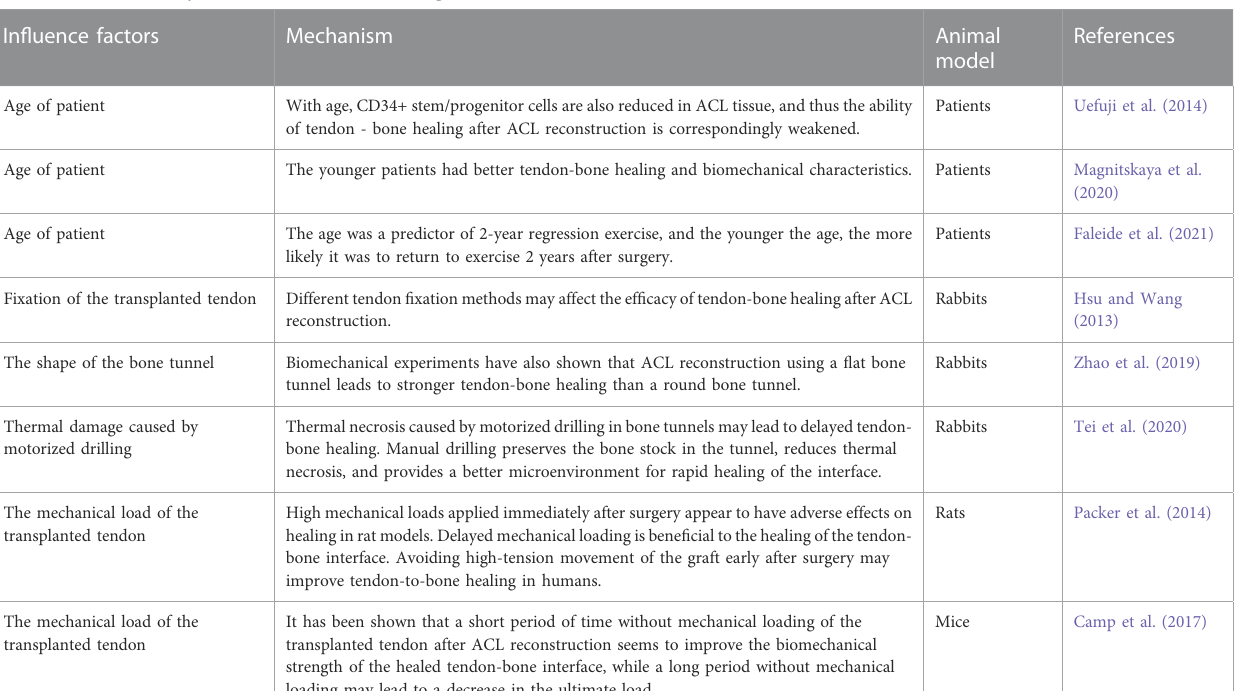
TABLE 1 Factors that may in fl uence tendon-bone healing after ACL